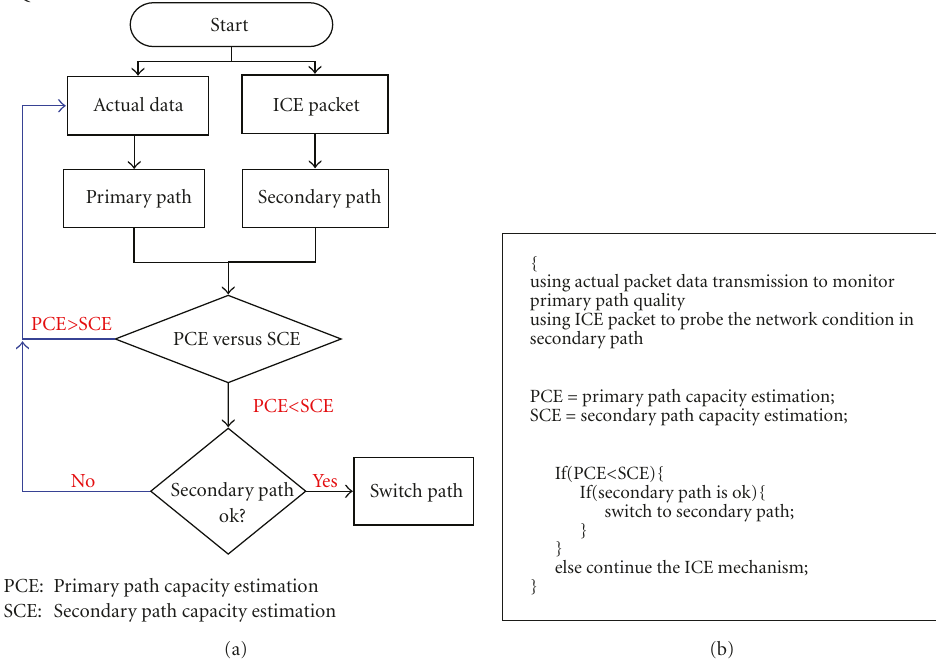
Figure 6: Path quality estimation and ICE mechanism pseudo code on the primary and secondary